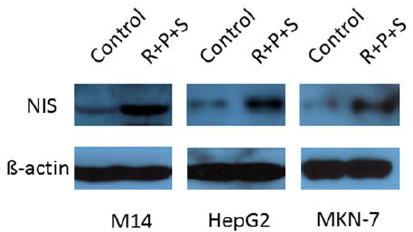
Figure 2. Western blotting analysis of NIS protein expression in M14, HepG2 and MKN-7 cells after treatment with the MEK, Akt and HDAC inhibitors. Cells were treated for 30 hrs with combination use of RDEA119, perifosine, and SAHA at the concentra- tions described in Fig. 1, followed by standard Western blotting analysis of cell lysates using the specific primary antibody against NIS. The expression level of ß-actin was analyzed in parallel for quality control. ‘‘Control’’, treatment of cells with vehicle; ‘‘R + P + S’’, treatment of cells with combined use of RDEA119, perifosine and SAHA.